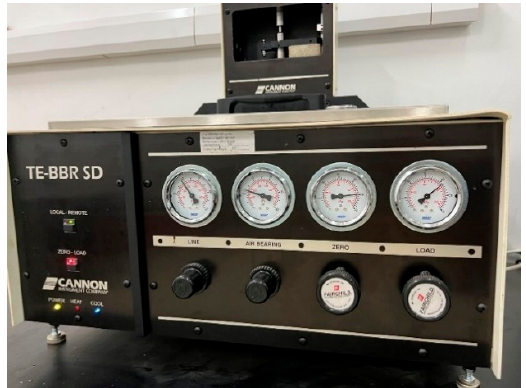
Figure 6. Bending beam rheometer TE-BBR-F.